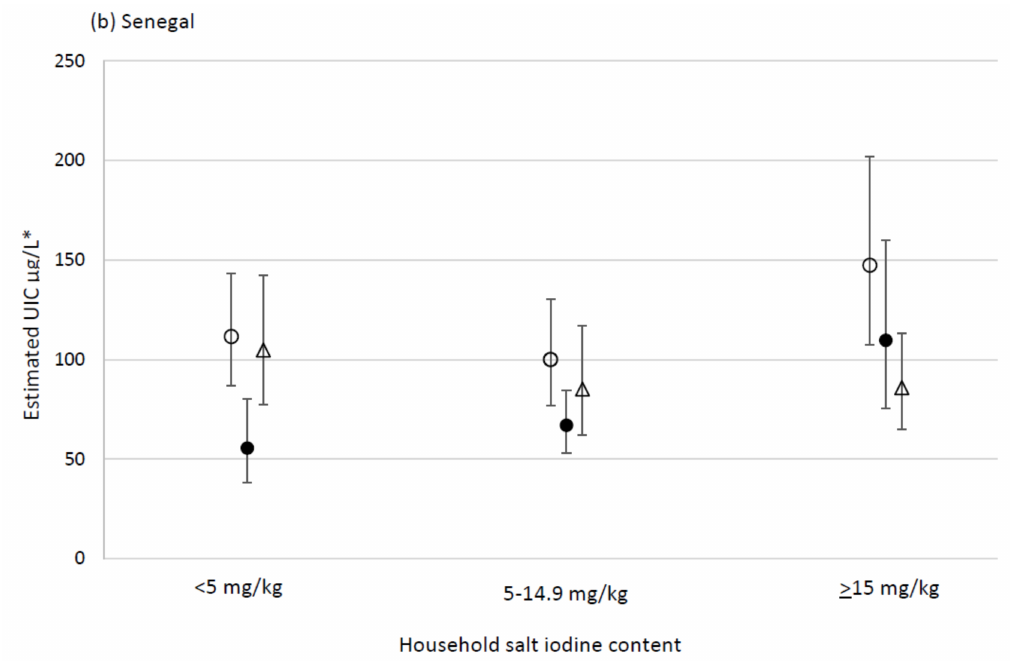
Figure 2. Multiple regression analysis including interaction with strata, to estimate predicted UIC ( µ g/L) among WRA according to household salt iodine category (mg/kg) in ( a ) Ghana Rural-non-salt-producing, ∆ Urban. * Adjusted estimates with 95% confidence intervals for urinary iodine concentration (UIC); back-transformed from a log-linear model adjusting for residence type; multi-dimensional poverty index (MPI) components; awareness of iodine deficiency; dietary diversity; age; estimated consumption of tomato paste, bouillon and instant